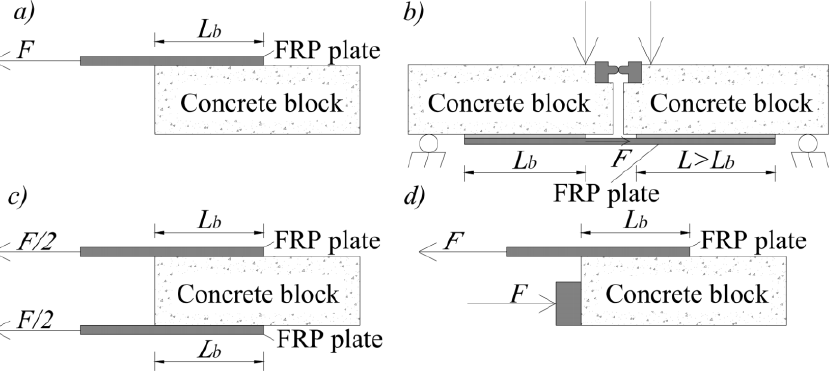
Figure 12. Pull-off/out shear tests ( a ) single lap shear (SLST); ( b ) bending shear (BST); ( c ) double lap shear (DLST); ( d ) push – pull shear (PPST).